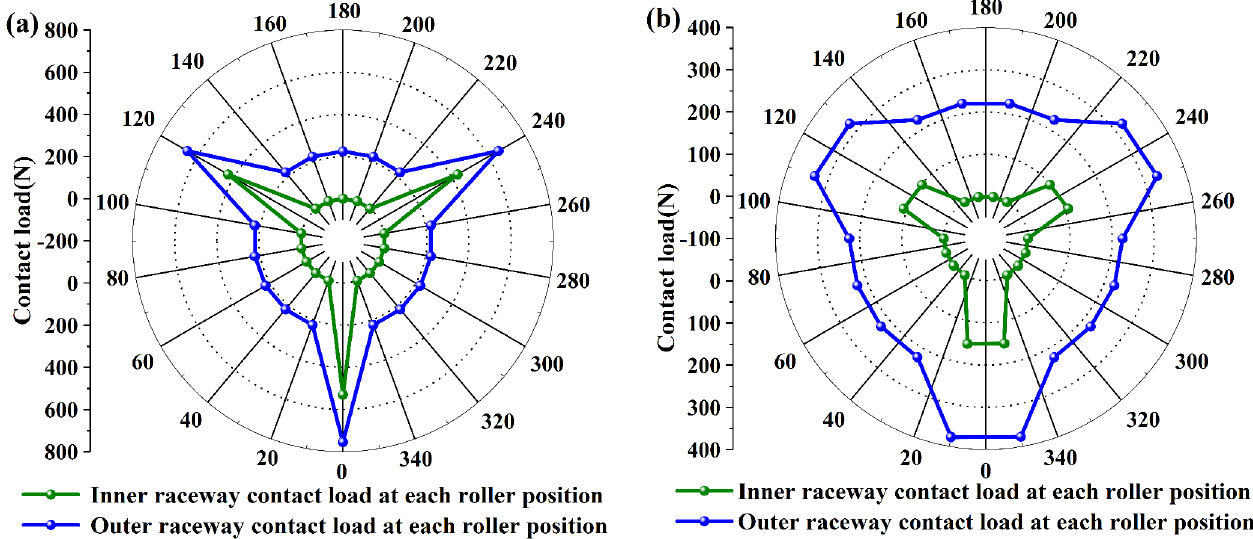
Fig. 6. The contact load distribution: (a) single-pressed state; (b) double-pressed state. Table 2. Comparison between the improved Newton-Raphson method and the original Newton-Raphson